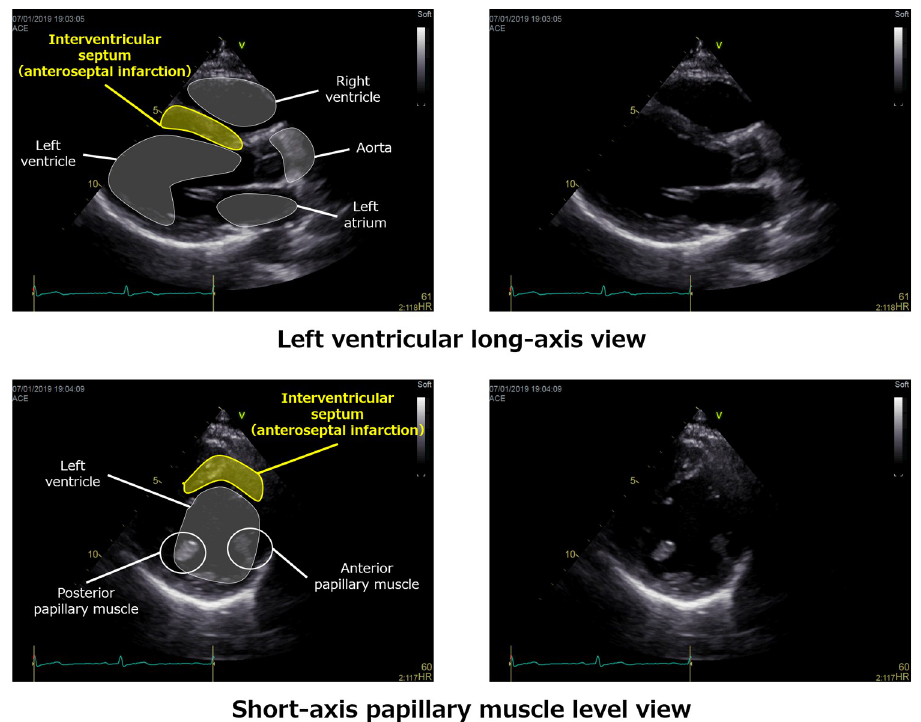
Fig 2. Left ventricular long-axis view and short-axis papillary muscle level view (left: views of anatomy; right: normal